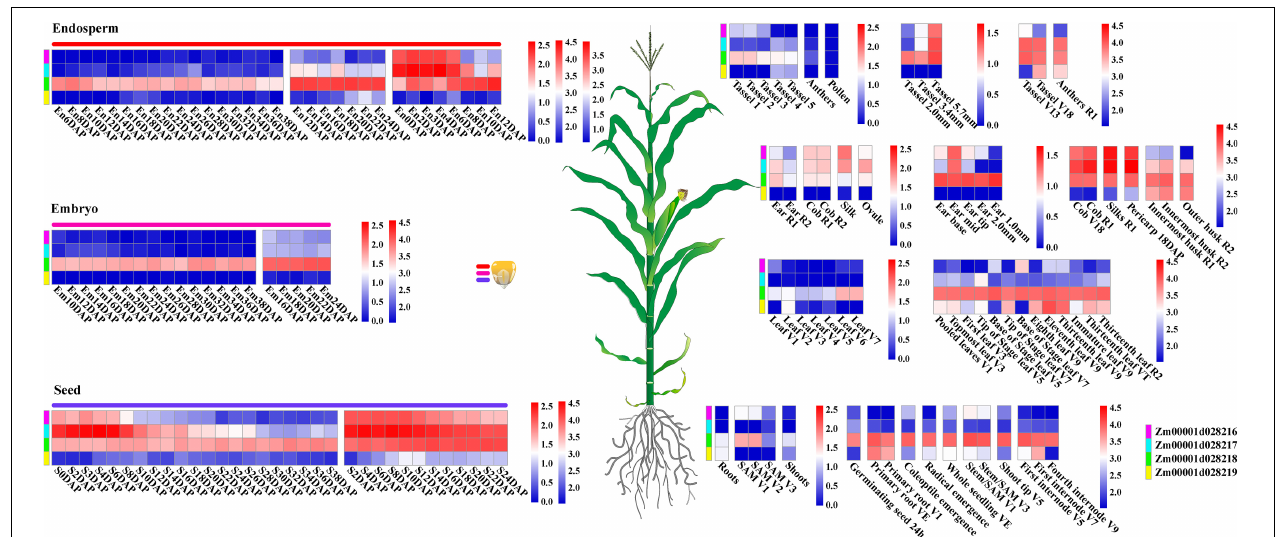
FIGURE 7 | Temporal and spatial expression patterns of regulation genes of EL and FL. Different expression modules in same tissue represent different expression data sources, and the scale bar shows the normalized expression values corresponded to different modules. Additionally, different colored bars represent four different